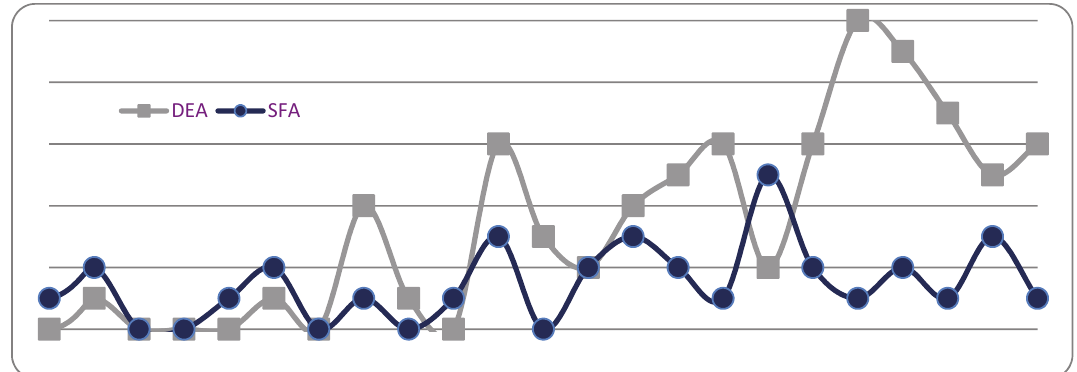
Fig. 6. Number of Life Insurance Efficiency Studies Using Different Methods of Determining Efficiency With no Author Duplication (Year-by-Year)